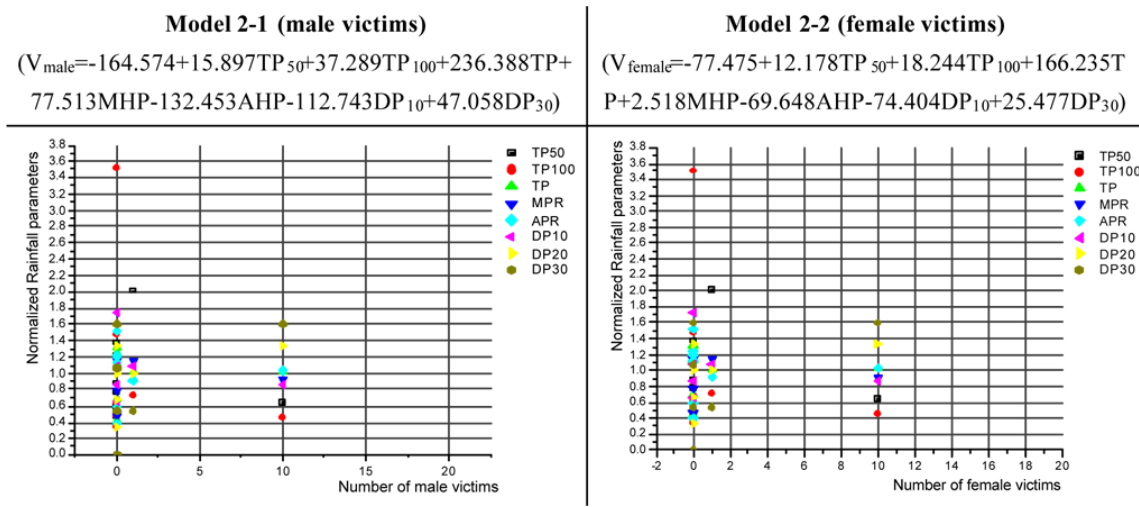
Fig. 12. The relationship between each extreme rainfall parameter and the number of male victims of the eight affected districts.